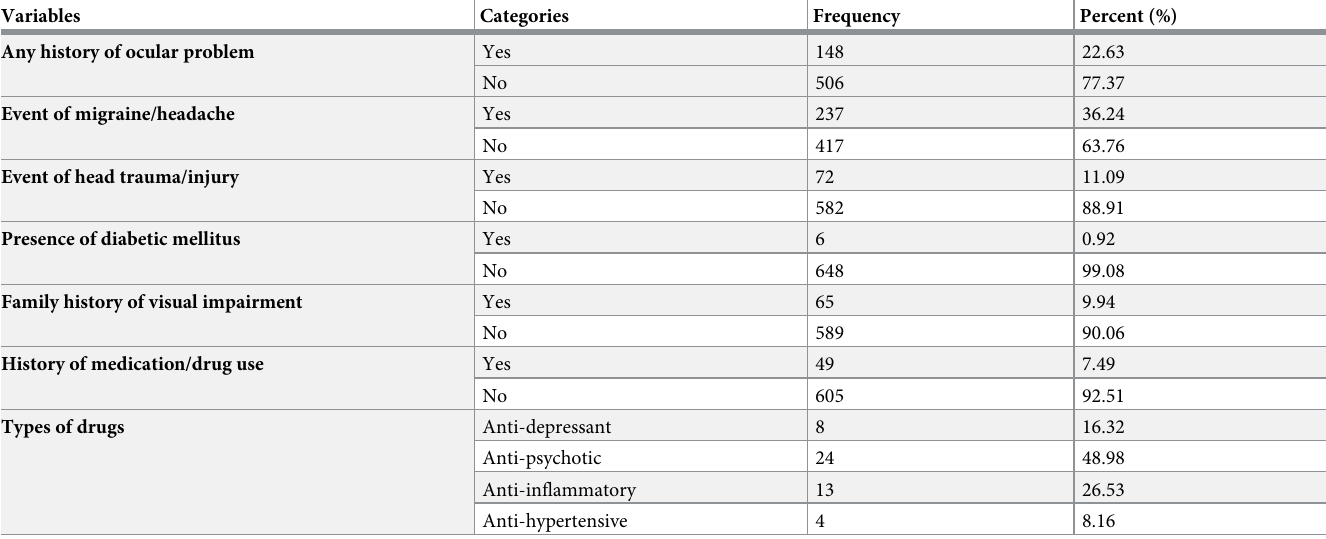
Table 3. Clinical characteristics of the study participants, College of Medicine and Health Science, University of Gondar, Ethiopia, 2020 (n = 654).